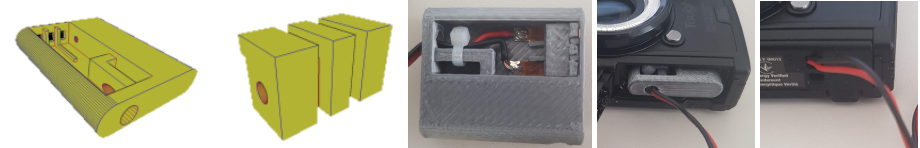
Figure 4. Designs of a battery emulator and photographs of its